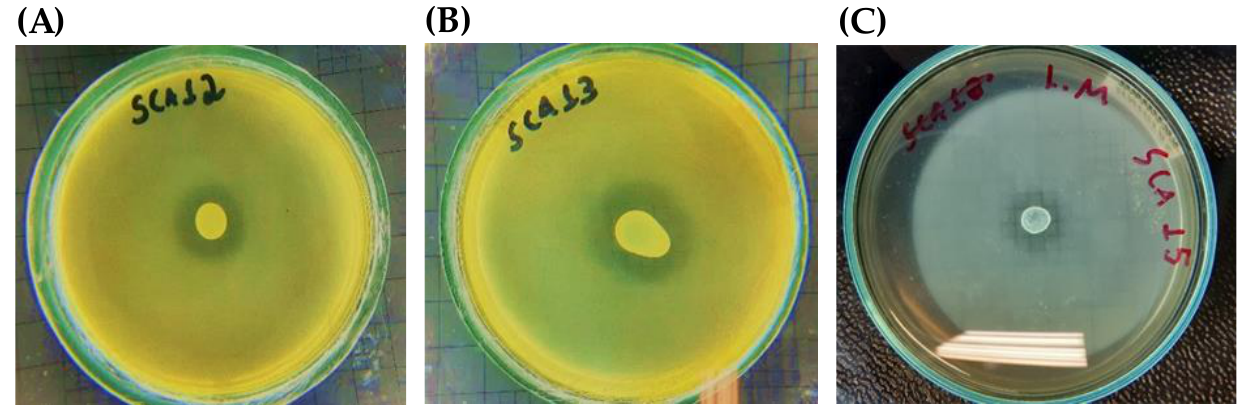
Figure 2. Spot-on-lawn assay results. ( A ) SCA12 bacterium showing growth inhibition halo against the indicator bacterium, B. cereus ; ( B ) SCA13 bacterium showing growth inhibition halo against the indicator bacterium, B. cereus ; ( C ) SCA15 bacterium showing a halo of inhibition against the indicator bacterium, L. monocytogenes